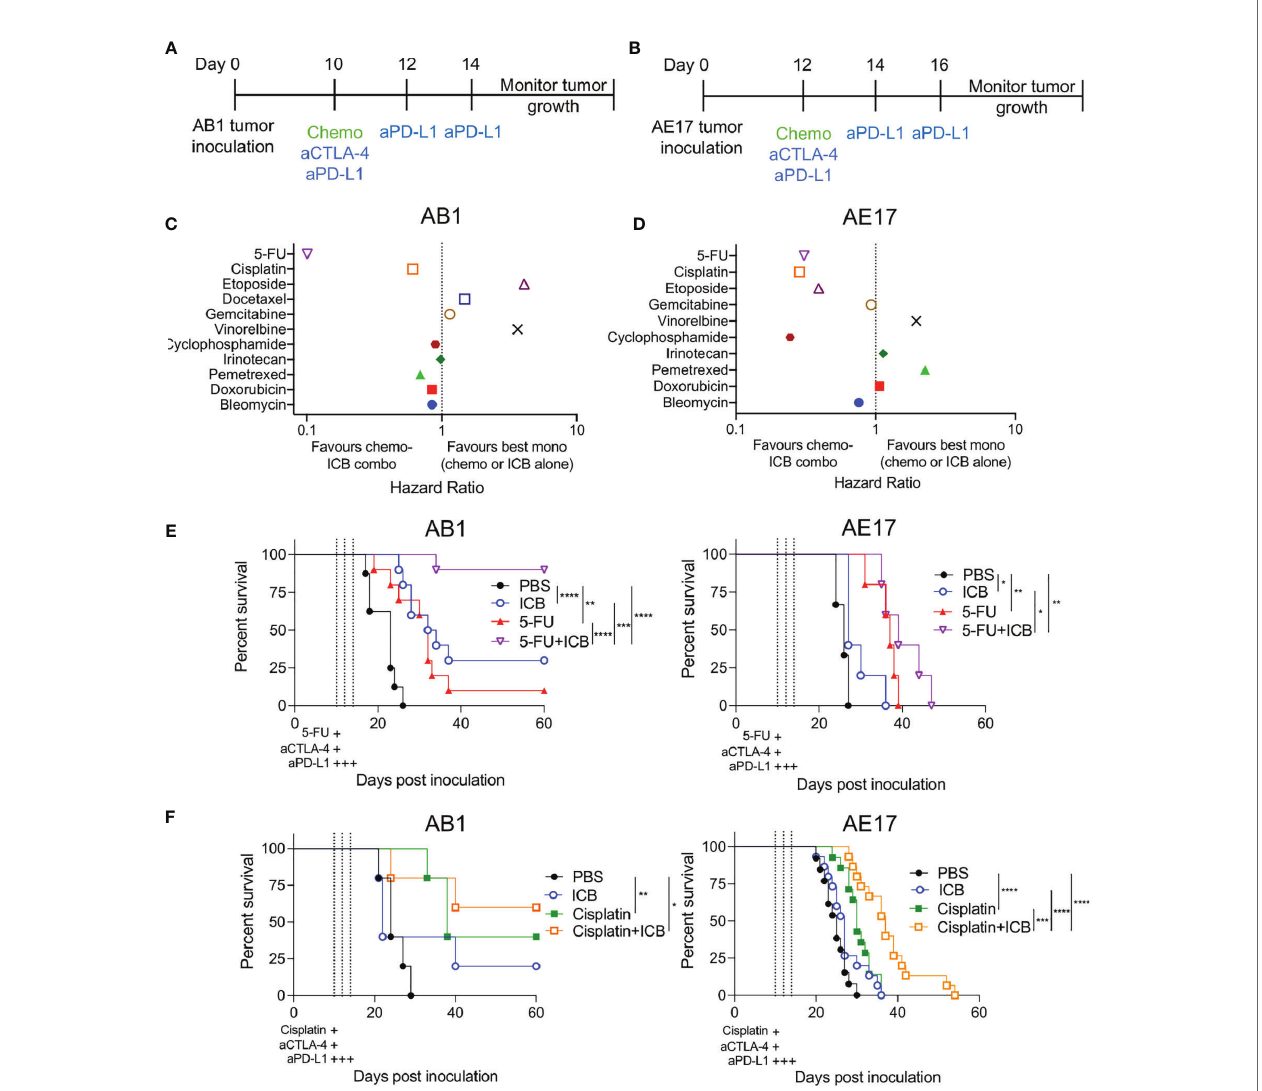
FIGURE 1 | Different combinations of chemotherapy and immune checkpoint blockade (ICB) demonstrate additive and antagonistic responses. (A, B) Treatment schedule for mice inoculated with AB1 (A) or AE17 (B) mesothelioma cell lines. (C, D) Hazard ratio (HR) analysis of survival plots comparing combination chemotherapy and ICB (anti-CTLA ‐ 4/anti ‐ PD-L1) to the best performing monotherapy in AB1 (C) and AE17 (D) . HR is de fi ned as the risk of a negative (death) outcome occurring in one group at the next instance of time, compared to another group at the same time. A lower ratio i.e., less than 1 indicates a higher rate of survival in the chemo-immunotherapy combination compared to monotherapy. (E) Survival curves of 5-FU chemo-immunotherapy combinations in AB1 (left; n = 8-10 per group, two pooled experiments) and AE17 (right; n = 5 per group, one experiment). (F) Survival curves of cisplatin chemo-immunotherapy combinations in AB1 (left; n = 5 per group, one experiment) and AE17 (right; n = 13-15 per group, two pooled experiments). Mantel-Cox survival test; *P < 0.05, **P < 0.01, ***P < 0.001, ****P <